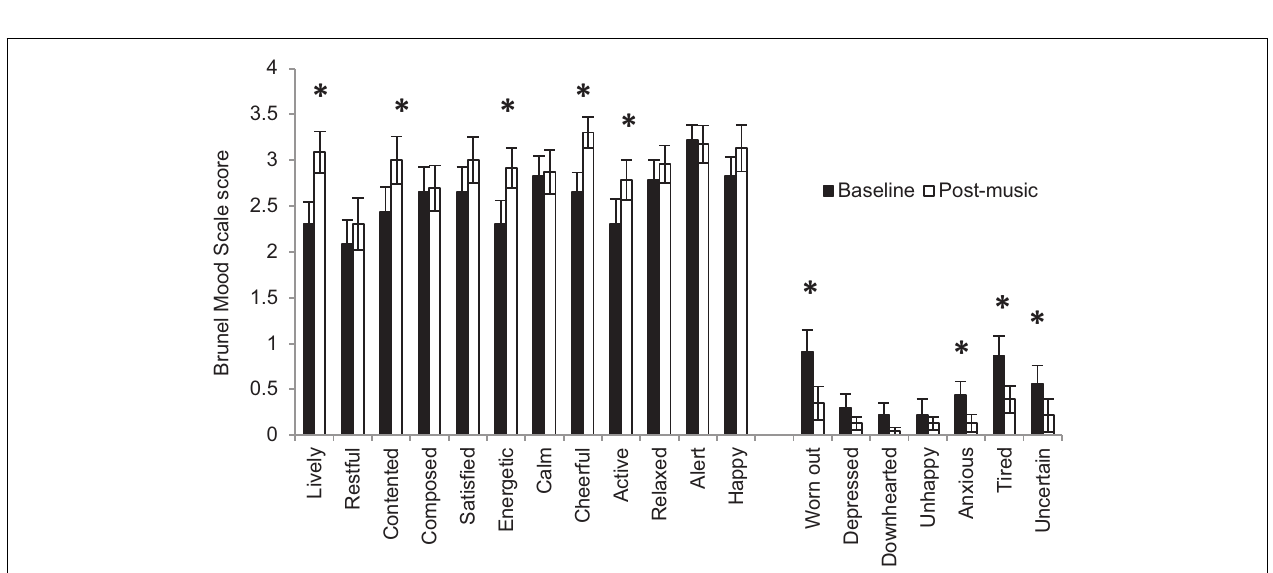
FIGURE 2 | Mean Brunel Mood Scale scores at baseline and after listening to self-selected music . Error bars represent the standard error. *Represents statistically significant differences at p < 0.05.